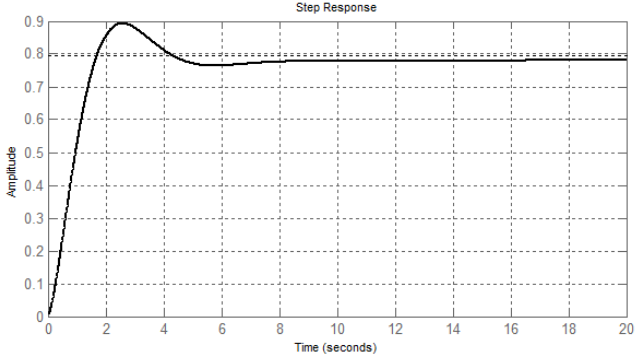
Figure 11. The transition function in this case.